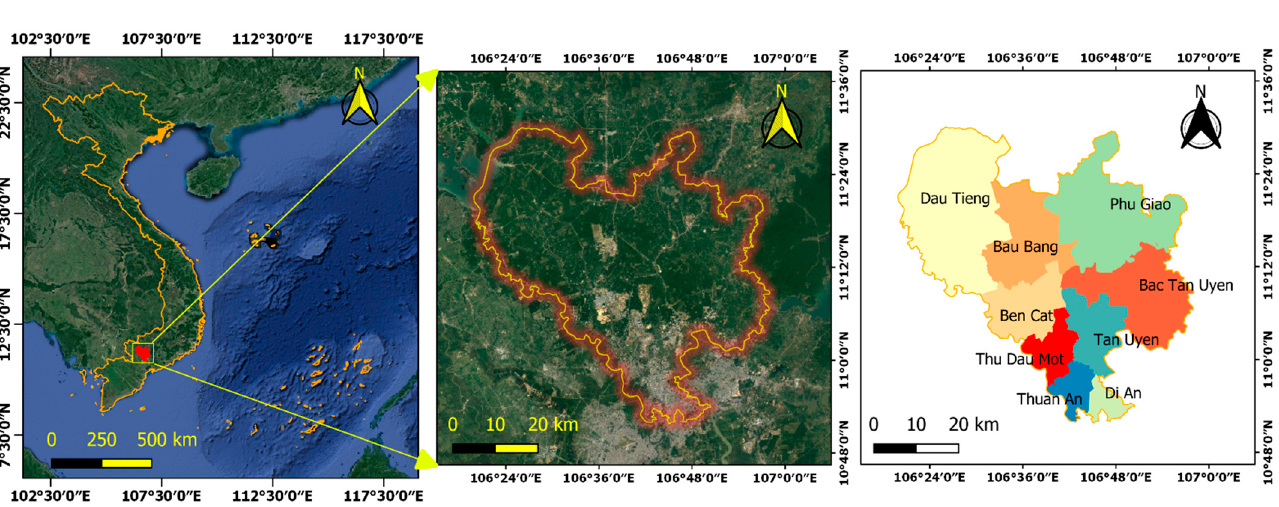
Figure 1. The study area.